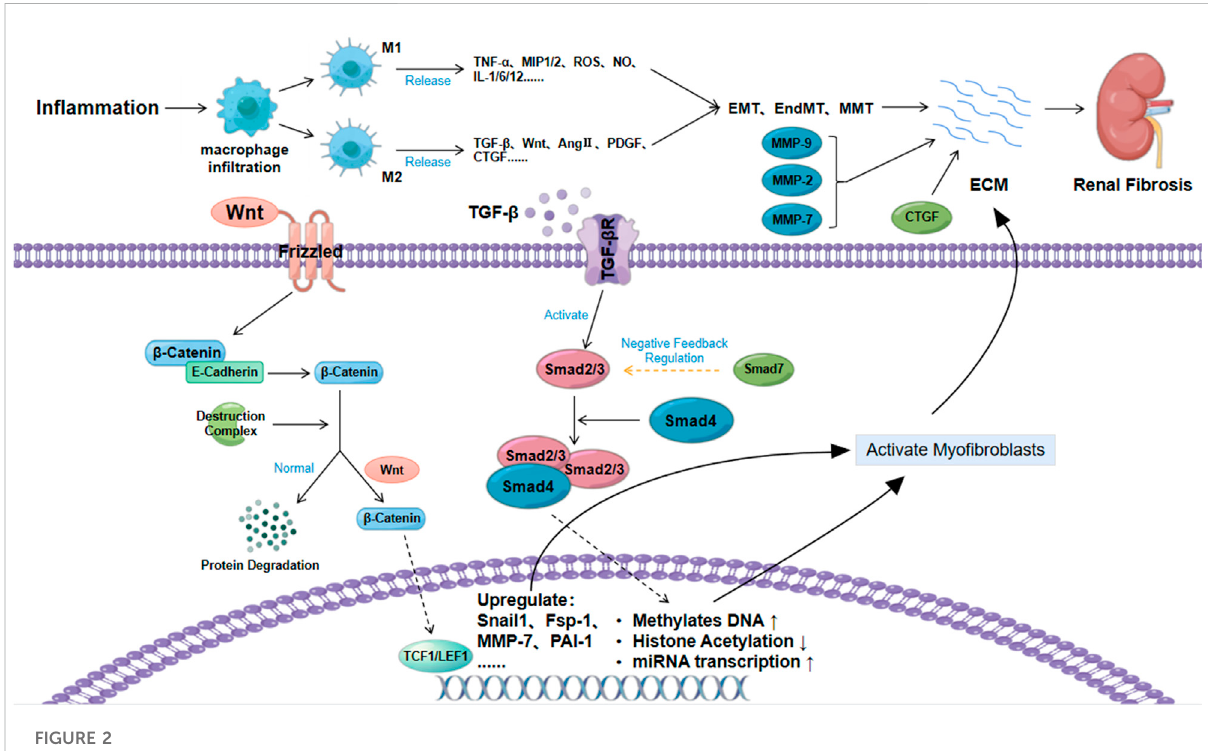
FIGURE 2 Formation of the fi brous